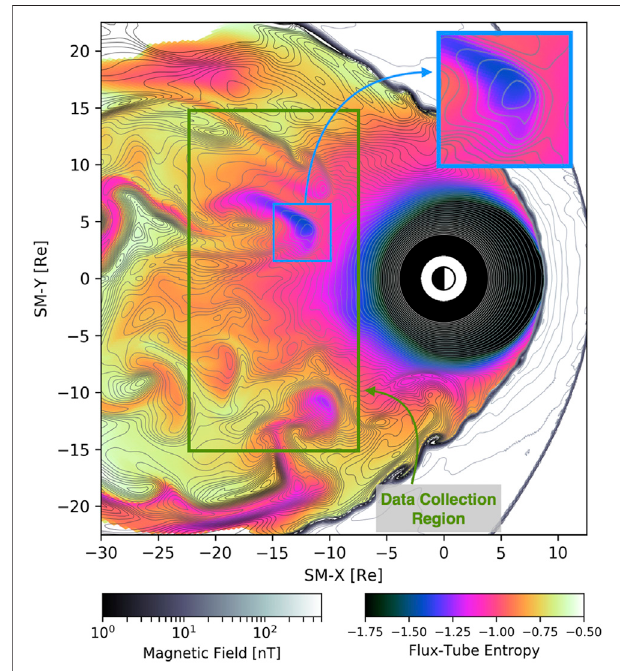
FIGURE2| MHD fl owstructuresinthetransitionregion.Snapshotofthe simulation at the same time as Figure 1 showing the integrated fl ux tube entropy (logarithmic scale) in the equatorial plane and contours of constant total magnetic fi eld strength. Green boundary depicts the domain from which we compile statistics of transport and acceleration in the transition region. Figure inset shows a typical “ magnetic island ” fi eld structure exhibited by BBFs in